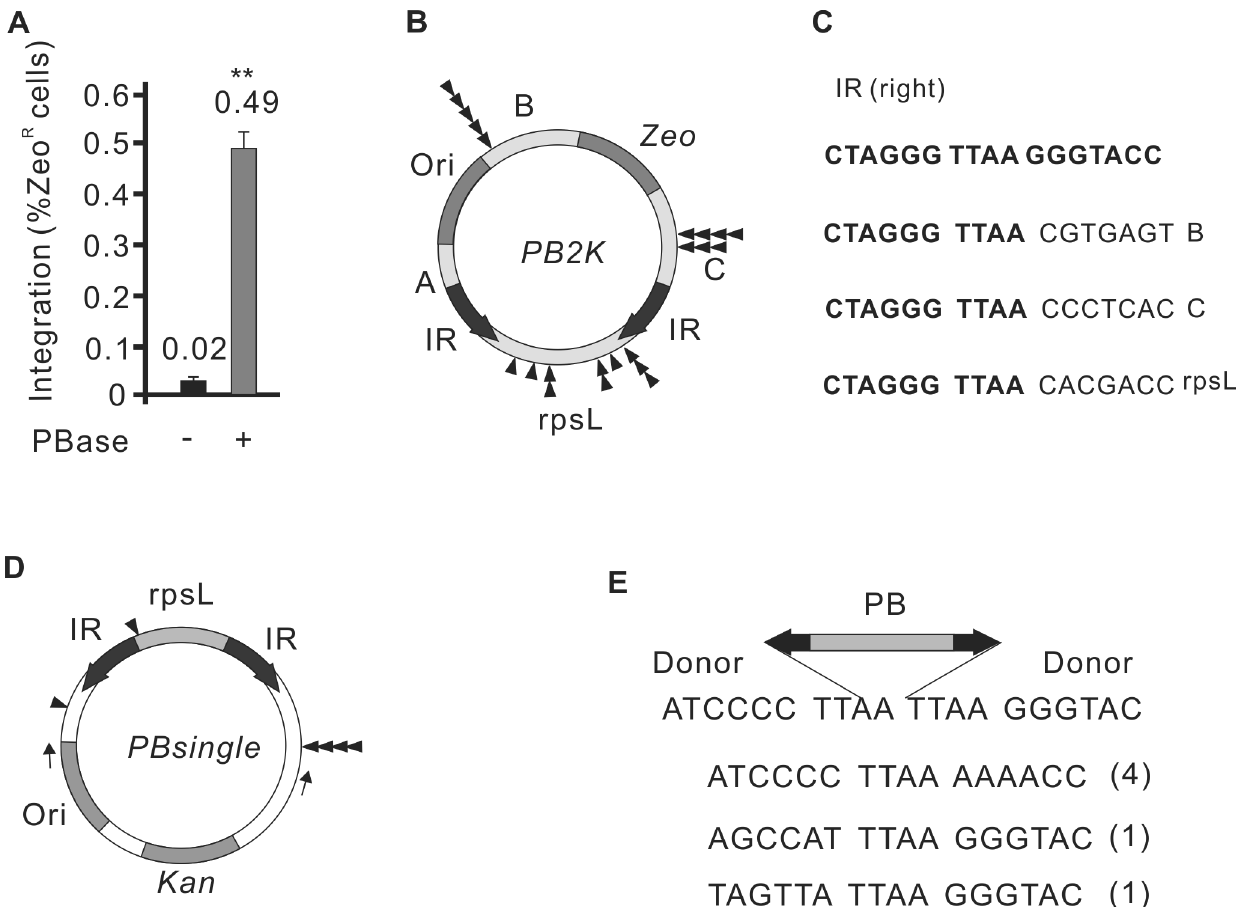
Figure 3. Autointegration properties of PiggyBac transposition. A. Frequency of PB autointegration events in HeLa cells using the PB2K construct. PBase, m PB transposase [50]. B. The structure of the PB2K construct. For explanation, see Figure 1A. Distribution of de novo PB insertions indicated by black triangles (n=22) on the PB2K construct. C. Sequence of three (3/22) representative single-ended transposition events mapped to the B, C and rpsL regions of PB2K . Sequences flanking the right inverted repeat of the PB transposon in PB2K . Original sequences (bold); de novo integration events (normal); target site of PB transposition, TTAA (italic). D. Distribution of six single-ended transposition events on the PBsingle construct. Kan : kanamycin resistant gene ( Kan ). Dark bars indicate the control experiment with only transposon vector; light bars indicate the experiment with both transposon vector and transposase expressing vector. E. Sequence of the six individual single-ended transposition shown on Figure 3D. The PB transposon is shown as a two-headed arrow, representing the IRs (black). Frequencies are shown in